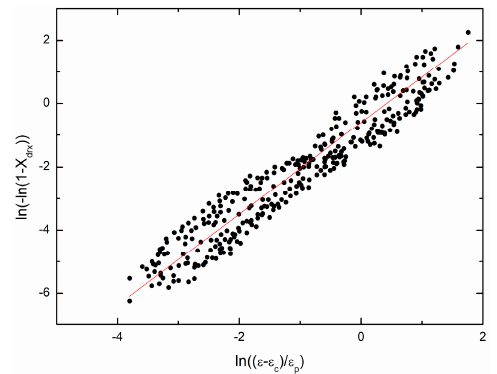
ln( ln(1 Figure 14. The relationship between ln ( − ln ( 1 − X